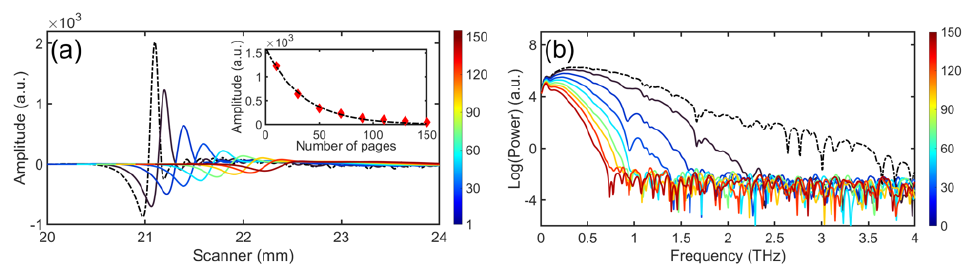
Figure 3. ( a ) THz signals (electric field) transmitted through paper stacks with various page count s ranging from 1 to 155. Inset shows the peak amplitude as a function of s in the paper stacks. ( b ) Power spectra of the corresponding transmitted signals shown in ( a ). The color bars indicate the number s of sheets in a stack corresponding to a given